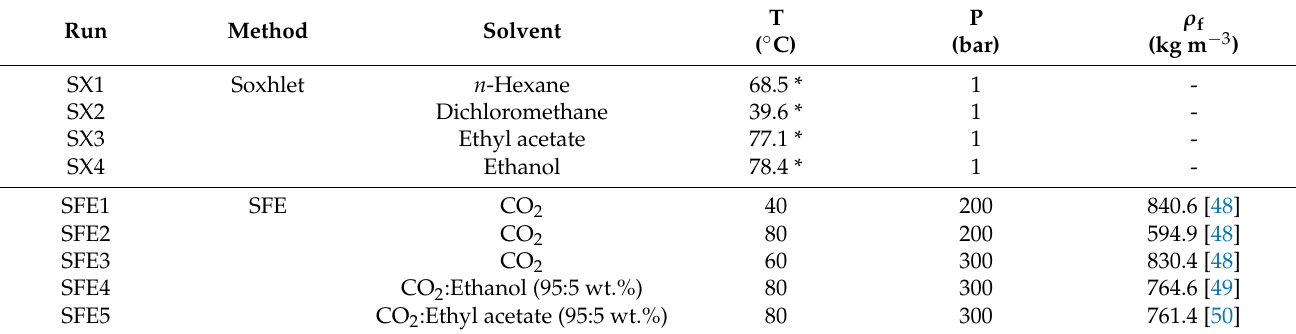
Table 1. List of Soxhlet and SFE assays with the respective operating conditions. Run